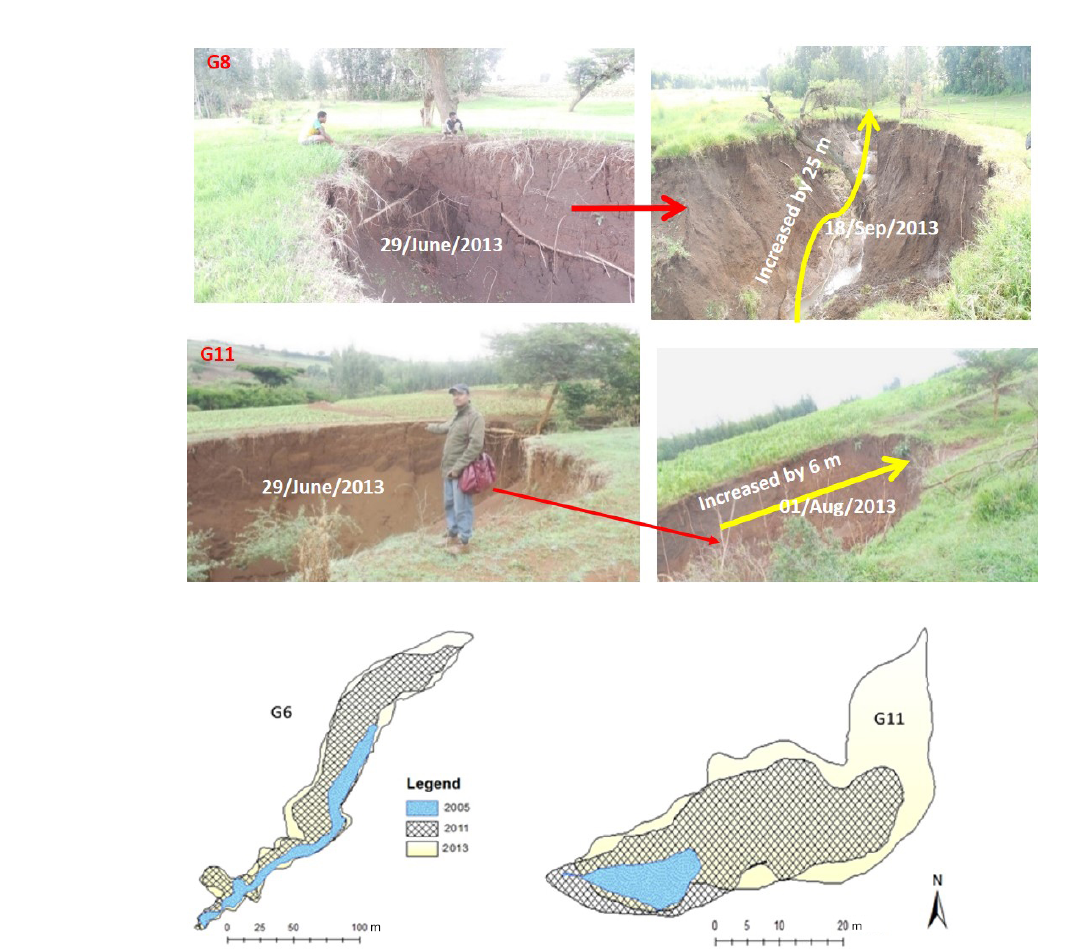
Figure 6. Examples of gully expansion in the Debre Mawi watershed. Top four photos: expansion of gullies G8 and G11 during the 2013 rain phase and the trees which fell into the gullies from upstream. Bottom images: expansion of gullies G6 and G11 between 2005 and